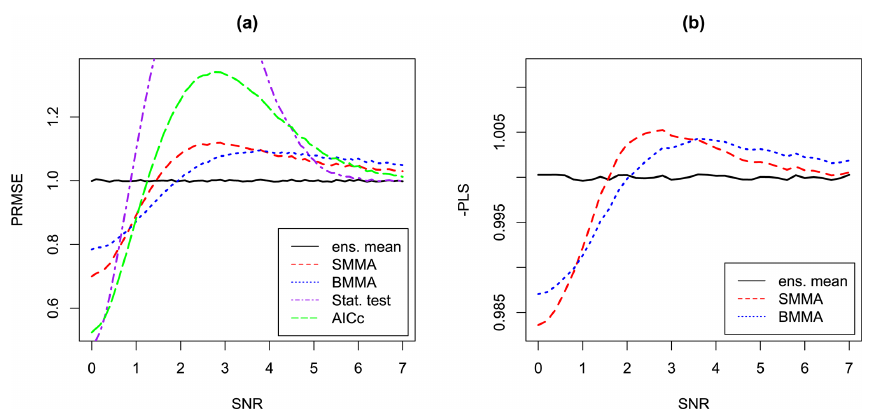
Figure 3. Results of a simulation experiment for quantifying the performance of the two plug-in model-averaging (PMA) methods compared with the ensemble mean, statistical testing, and AICMA. Panel (a) shows performance of point forecasts in terms of predictive root mean squared error (PRMSE). Panel (b) shows performance of probabilistic forecasts in terms of predictive log score (PLS). The horizontal black solid line in both panels is the performance of the unadjusted ensemble mean versus the real SNR, which would usually be unknown. The red dashed line in both panels shows the performance of the simple PMA (SPMA) scheme and the blue dotted line in both panels shows the performance of the Bayesian PMA (BPMA) scheme. In panel (a) the purple dot-dashed line shows the performance of statistical testing and the green long-dashed line shows the performance of AICMA.